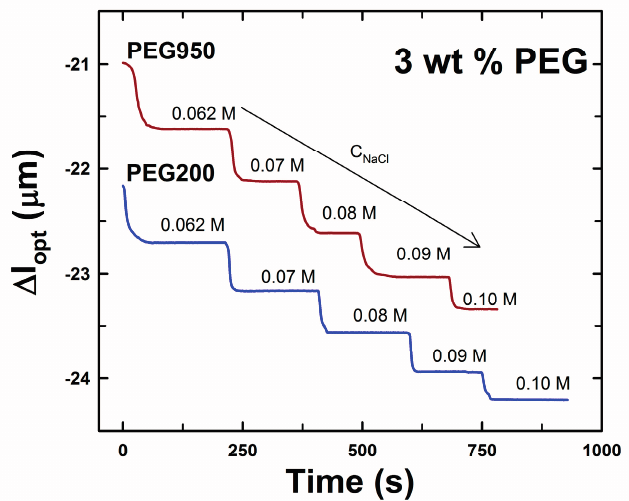
Figure 3. Deswelling kinetics of AMPSA -co- AAm hydrogels consisting of 10 wt % AAm, 3 mol % Bis (relative to AAm) and 3 mol % AMPSA (relative to AAm) with 3.33 wt % PEG200 ( l opt = 61.7 µm) and PEG950 PEG ( l opt = 62.1 µm) polymers removed right after synthesis. The data are selected for the NaCl concentration range ( c NaCl ) from 0.05 to 0.1 M, as indicated (Region I in Figure